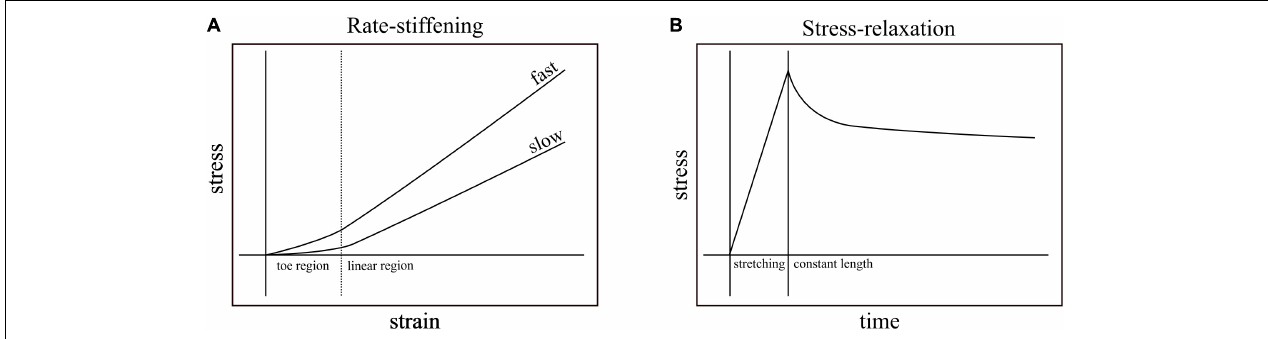
FIGURE 1 | Rate-stiffening and stress-relaxation are two mechanical behaviors that result from the viscoelasticity of biological structures. (A) In rate-stiffening, faster rates of strain increase the effective stiffness of the structure, resulting in higher stress for a given strain. These effects can be seen in both the toe region (left of dotted line) and the linear region (right of dotted line). (B) Stress-relaxation results from holding a structure at constant length (right of solid line) upon the completion of stretching. Over time, the stress required to maintain constant length is reduced as the energy stored in the structure dissipates into the